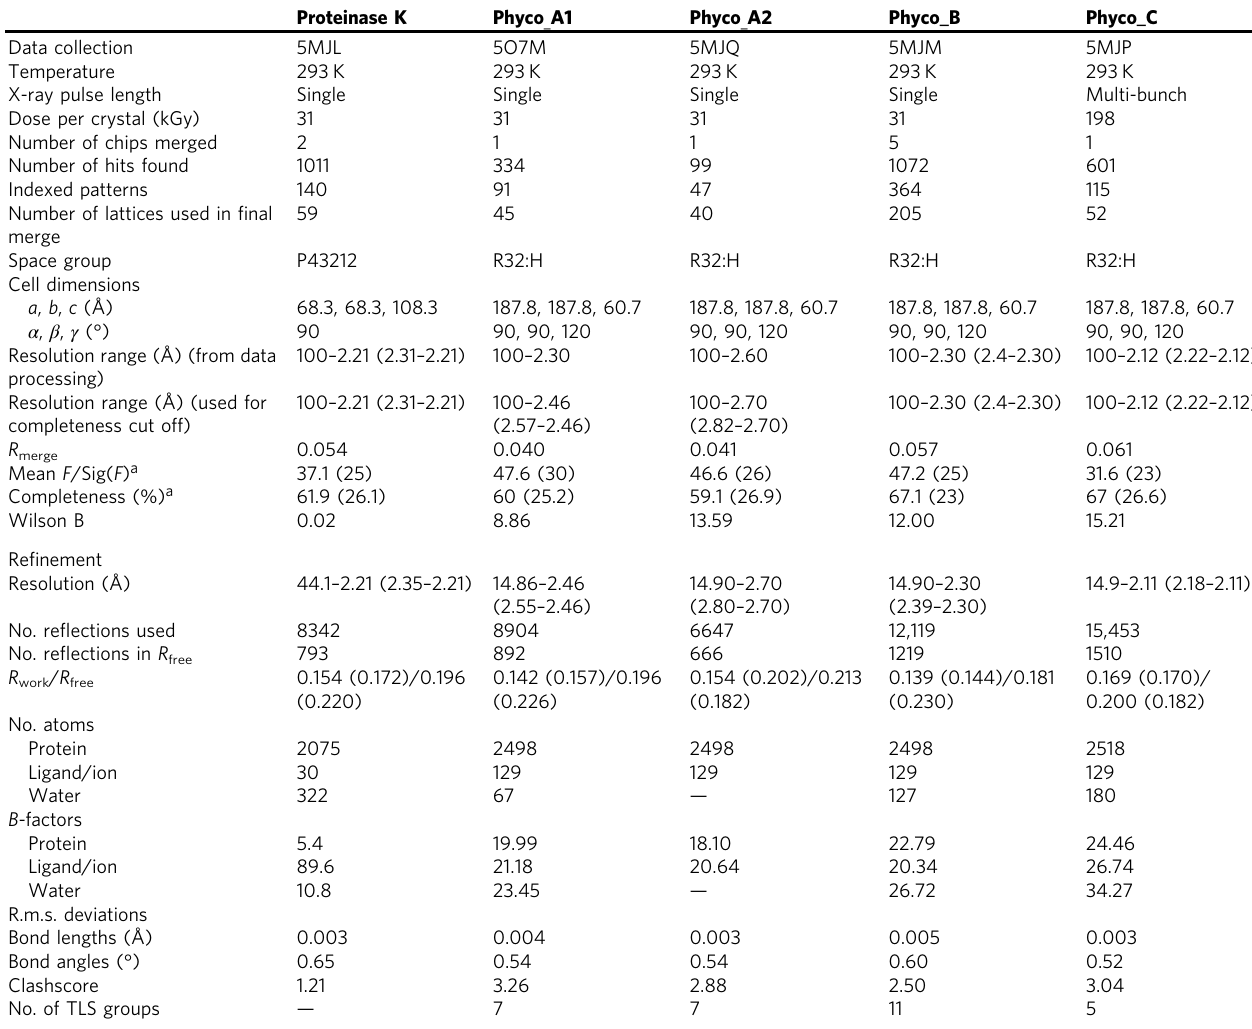
Phyco_A1, Phyco_A2, and Phyco_B datasets were measured with the APS single bunch in hybrid mode, Phyco_C with 3.68 µ s exposures (single pulse plus eight septuplets in hybrid mode). Phyco_A1, Phyco_A2 and Phyco_C contain from a single chip only, whereas Phyco_B contains merged diffraction data from 5 chips (1, 6, 7, 8, 11) a Values in parenthesis are for the outermost resolution